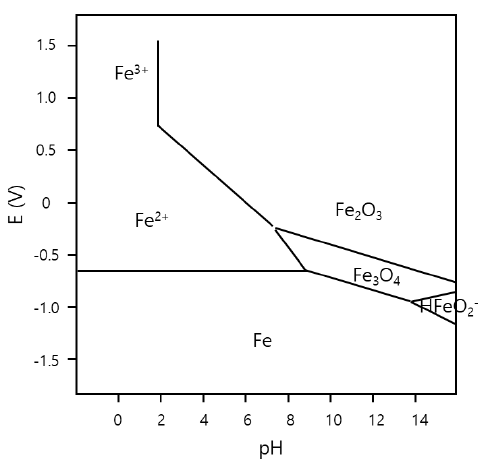
Figure 1. E-pH diagram of Fe in water at 25 °C, assuming [Fe 2+ ] = 10 −6 .